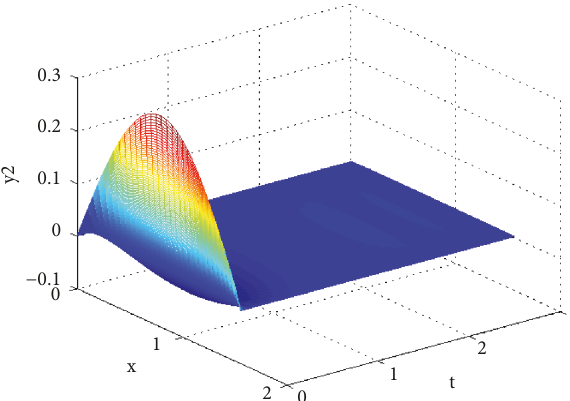
Figure 10: The closed-loop trajectory of 𝑦 2 (𝑥,𝑡)